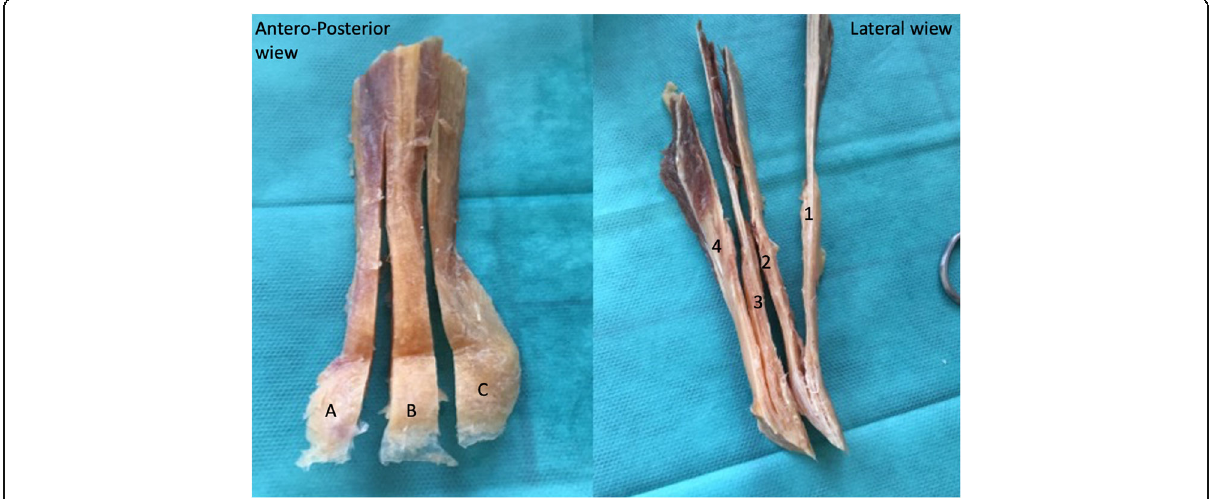
Fig. 2 Quadriceps Tendon specimens Preparation / A = QT Lateral /B = QT Central / C = QT Medial/ 1 = Superficial layer of the medial zone / 2 = Deep layer of the medial zone / 3 = Superficial layer of the central zone / 5 = Deep layer of the central